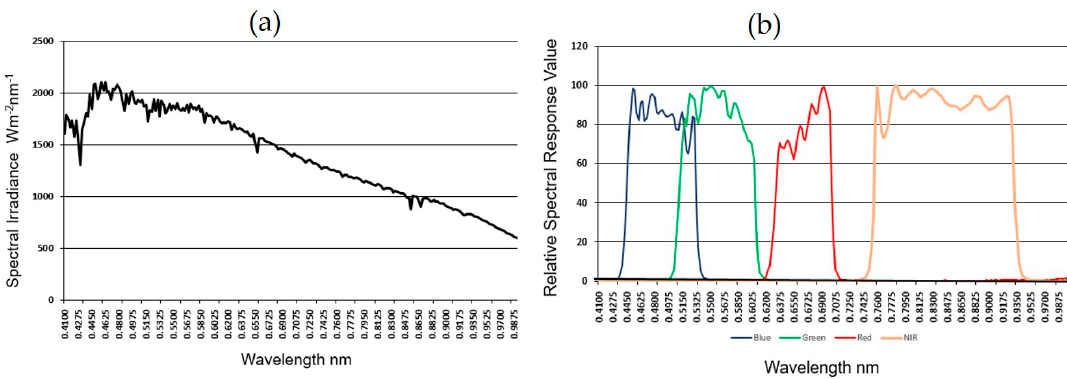
Figure 4. ( a ) Solar spectral irradiance based on ASTM G-173 [40] and ( b ) the relative spectral response of KOMPSAT-3A [16].